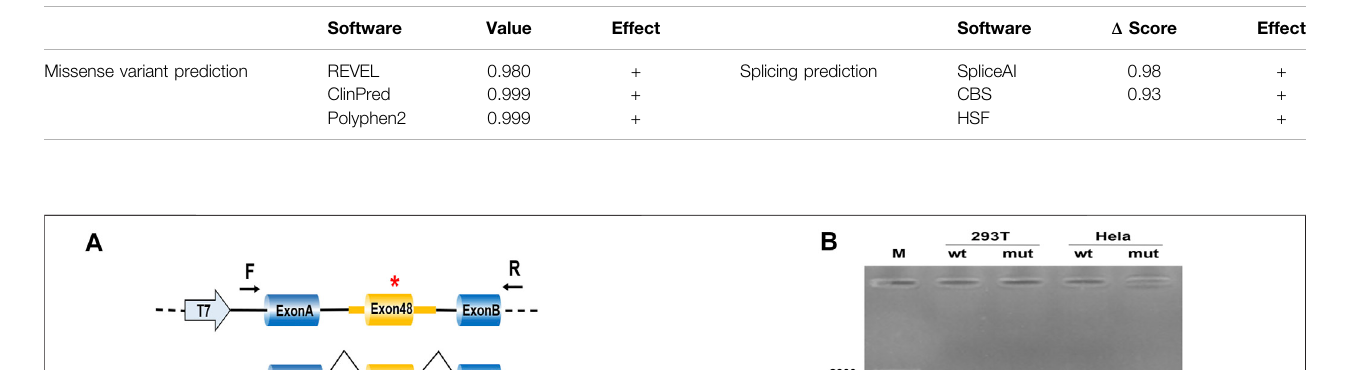
TABLE 1 | In silico analysis of the COL2A1 variant c.3392G > T.